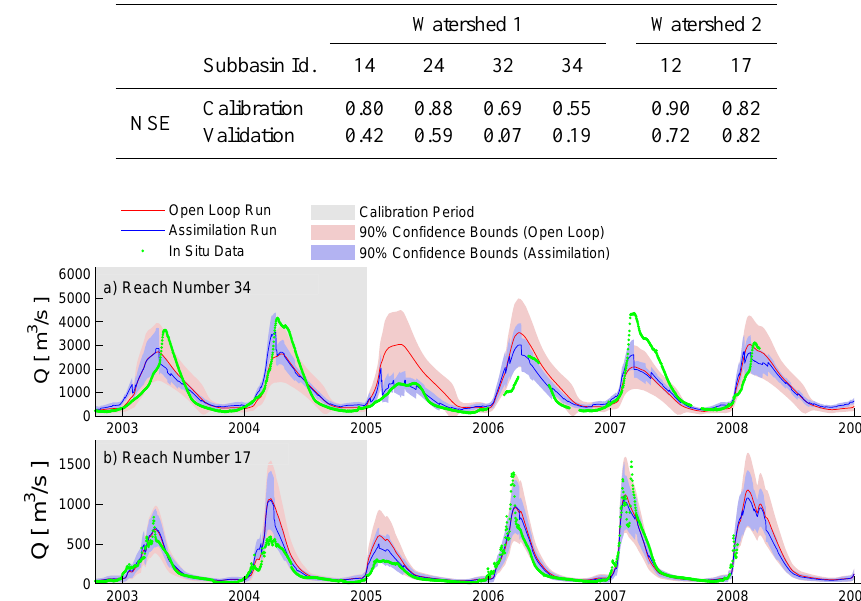
Fig. 3. Open loop (OL) and assimilation (Assim) results at the outlet of (a) watershed 1 and (b) of watershed